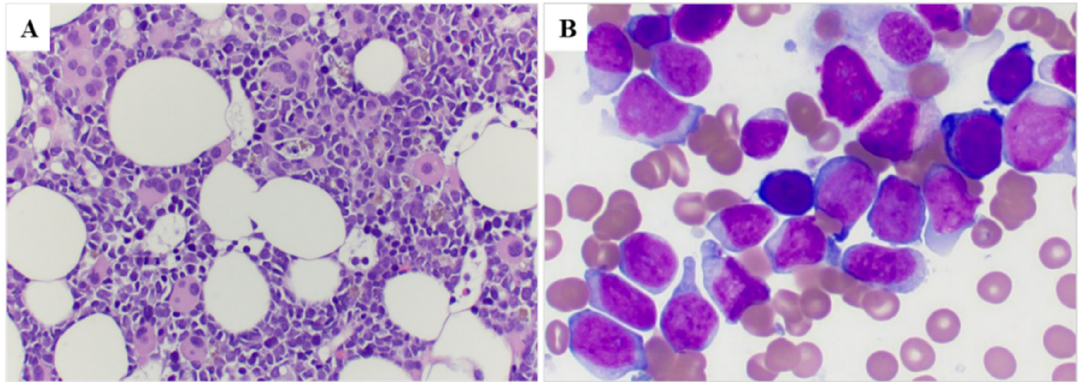
too few cells to evaluate.